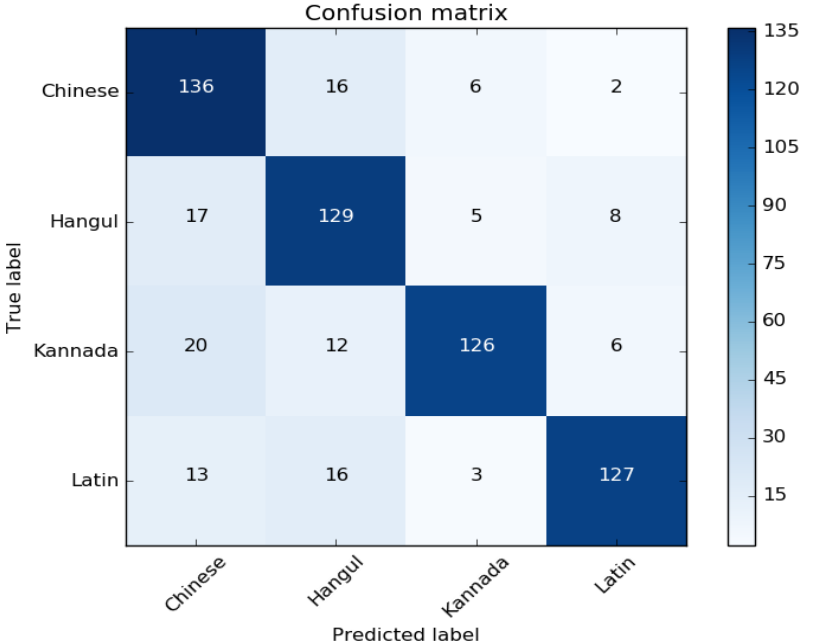
Figure 9. Confusion matrix on MLe2e dataset using VGG-16 fine-tune model with SGD with momentum